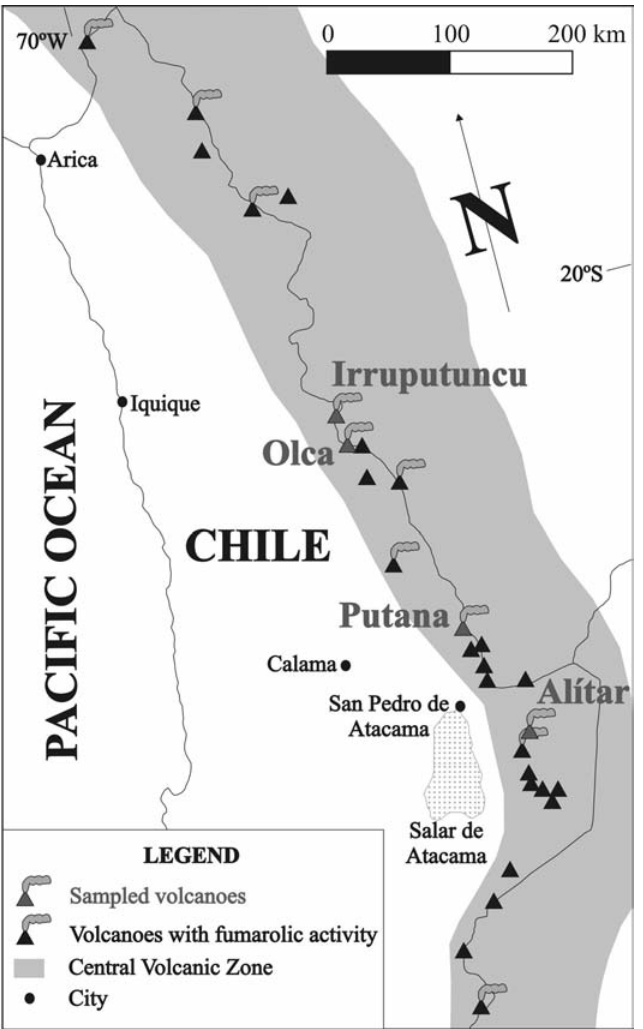
Figure 1. Schematic map of the central volcanic zone of the Andes in northern Chile, with the locations of the Irruputuncu, Olca, Putana and Alitar